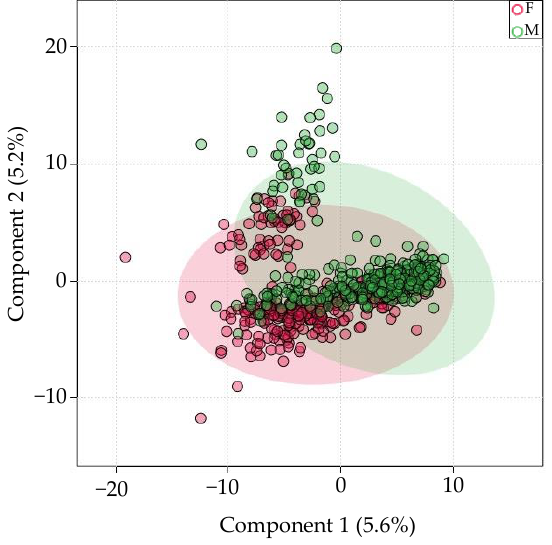
Figure 3. There is minimal sex-specific miRNA expression variation in saliva. PLS-DA-plot of the most consistently present miRNA in saliva, grouped by female (F, red) or Male (M, green) sex.